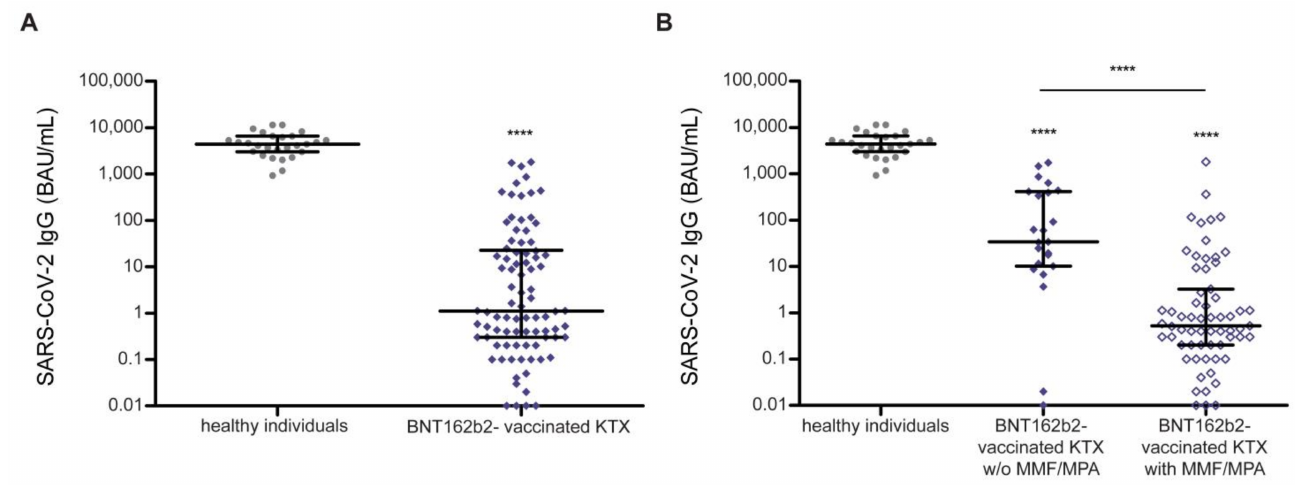
Figure 3. Vaccine-induced humoral response quantified by anti-SARS-CoV-2 IgG titers in kidney transplant recipients and healthy individuals. ( A ) Vaccine-induced anti-SARS-CoV-2 IgG titers in kidney transplant recipients are impaired compared to healthy individuals. ( B ) Vaccine-induced anti- SARS-CoV-2 IgG titers are significantly elevated in kidney transplant recipients with immunosuppres- sion lacking mycophenolate mofetil/mycophenolic acid. Vaccines used: BNT162b2 (BioNTech/Pfizer Mainz, Germany/New York, NY, USA) in kidney transplant recipients, and mRNA-1273 (Moderna, CA, United States) in healthy individuals. A Kruskal–Wallis test across all groups was used to indicate differences with respect to healthy individuals. A Mann–Whitney U test was used to indicate differences between two groups (**** p < 0.0001). Data are represented as median ± interquartile range and each patient is depicted by a single dot. IgG: immunoglobulin G; BAU: binding